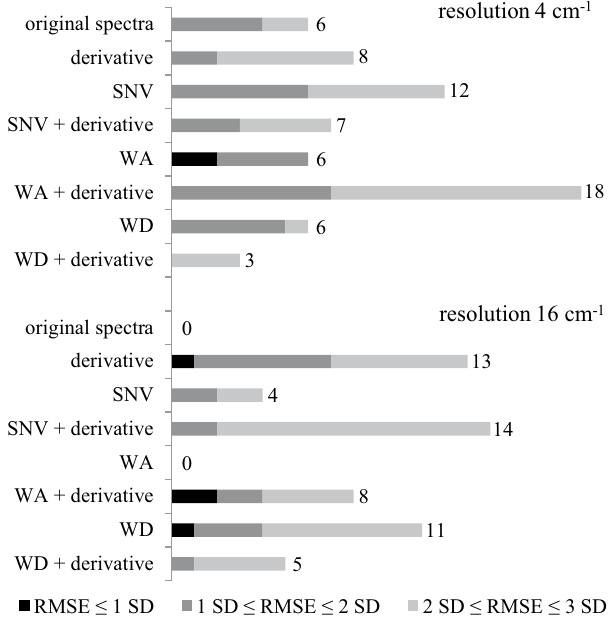
Figure 3. Number of models obtained with different pretreatment techniques and measured at two different resolutions. The numbers next to the columns represent the total number of obtained useful